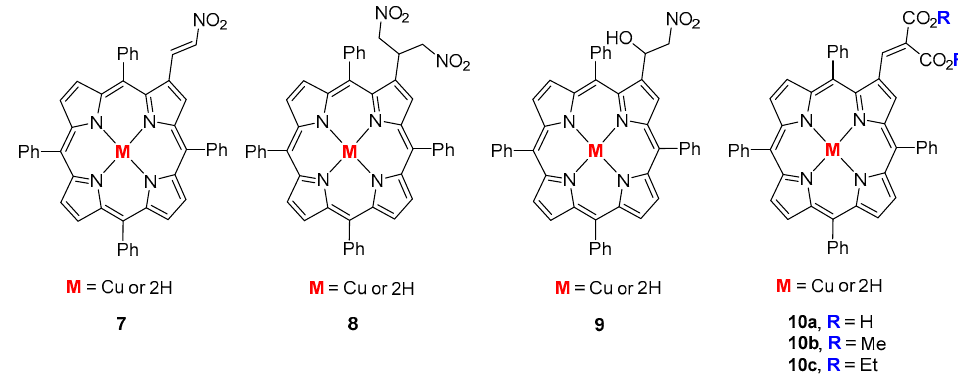
Figure 5. Products from the condensation of β -CHOTPP or its Cu(II) complex with nitromethane or malonic acid derivatives [91].